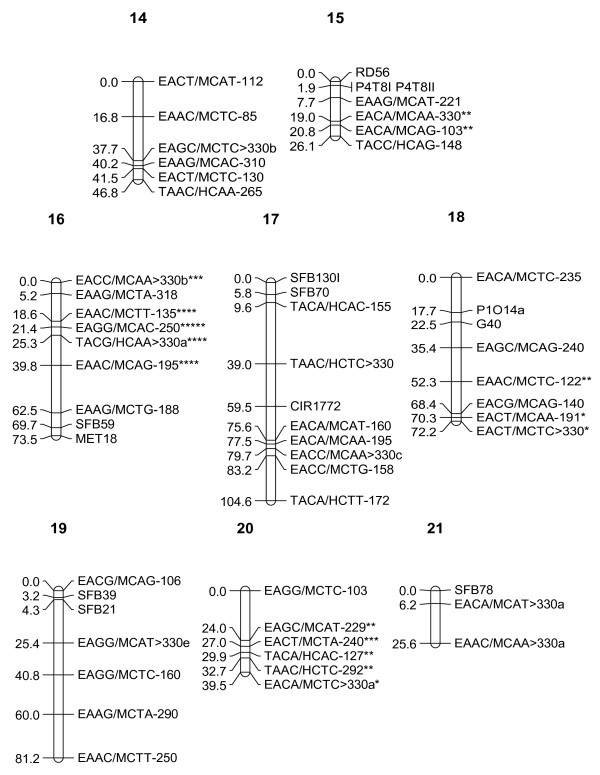
Combined AFLP, SSR and RFLP Map of interspecific hybrid (Palm T128) (Linkage Groups 14–21). Single asterisk: skewed marker at P < 0.1; double asterisk: skewed marker at P < 0.05; three asterisks: skewed marker at P < 0.01; four asterisks: skewed marker at P < 0.005; five asterisks: skewed marker at P < 0.001; six asterisks: skewed marker at P < 0.0005.